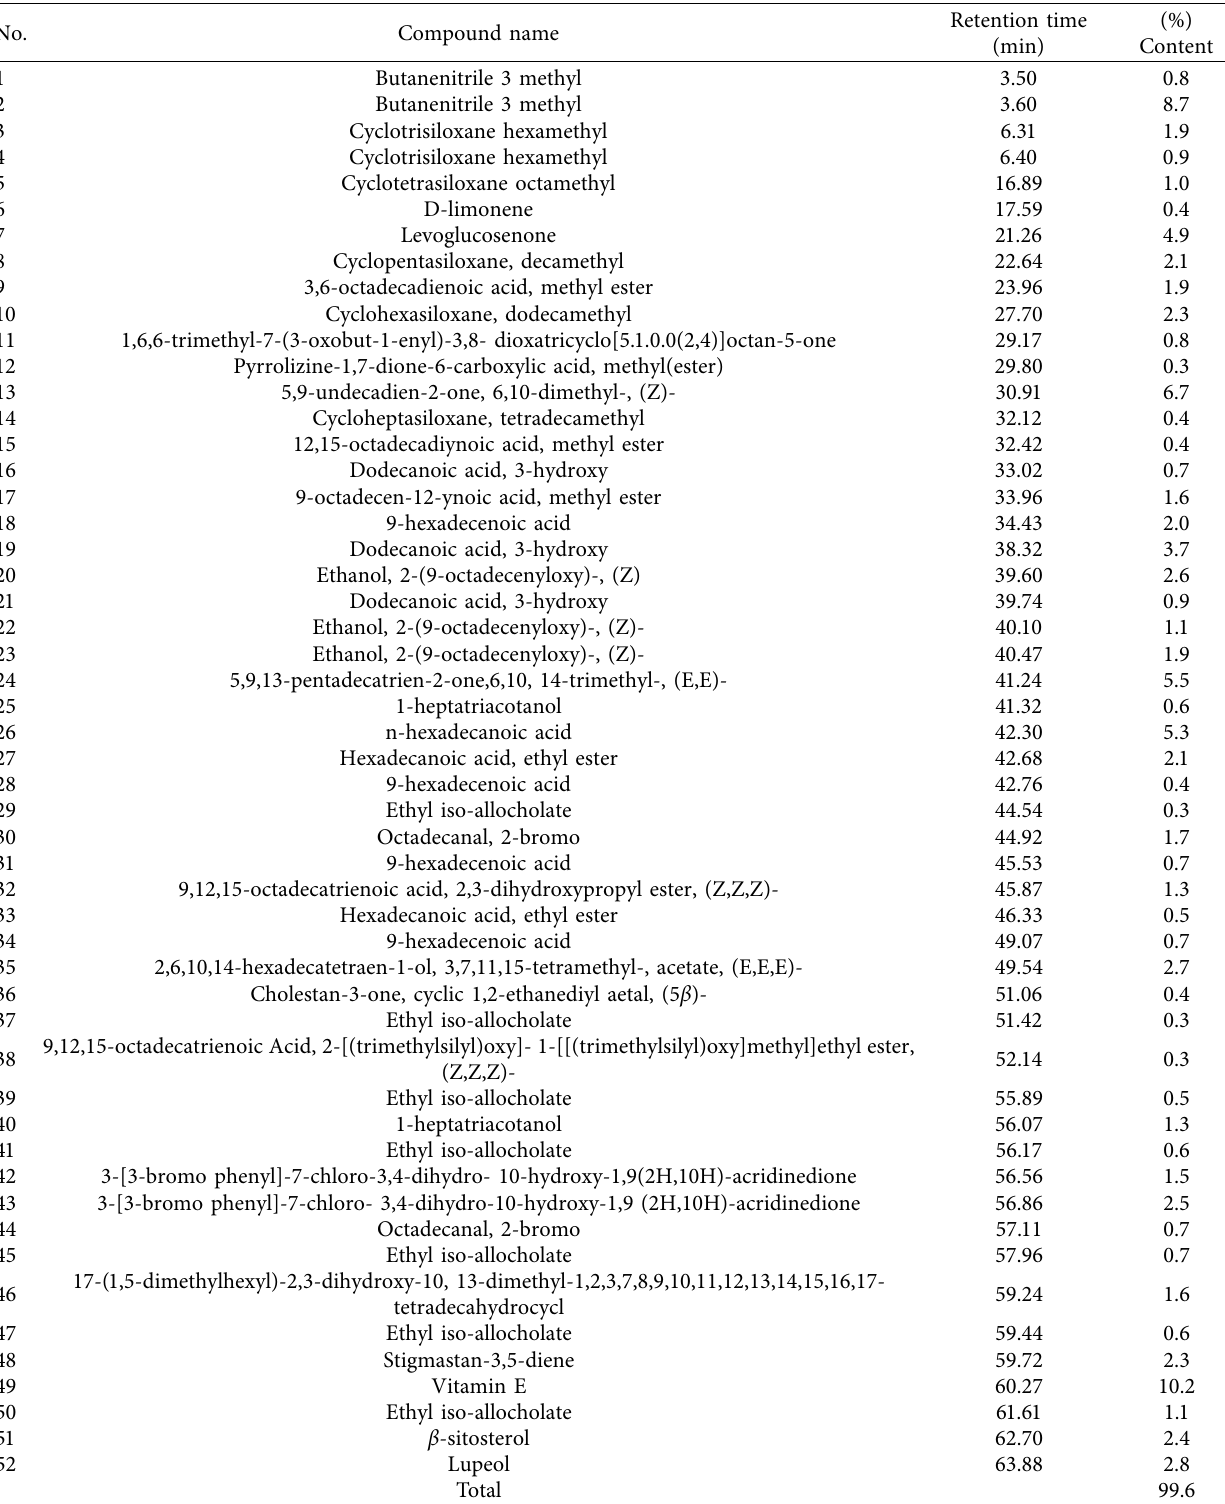
Table 3: GC-MS analysis of Moringa p eregrina